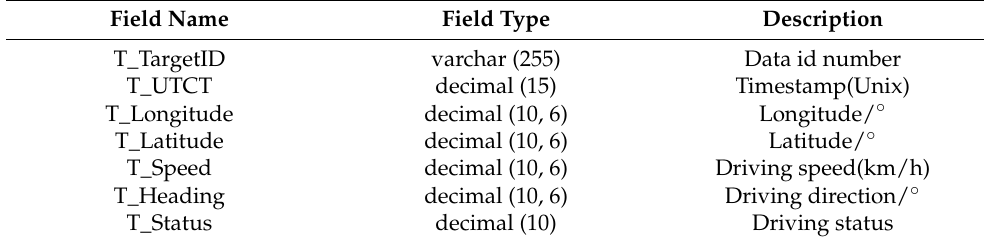
Table 4. Common taxi trajectory data table.